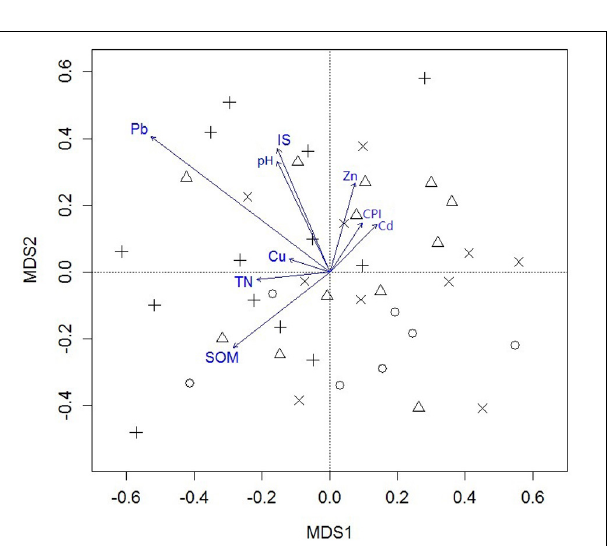
FIGURE 6 | Non-metric multidimensional scaling (NMDS) plot of soil mesofauna community structure (Stress = 0.250; method = Chao) and the environmental variables fitted on the NMDS spaces. IS ratio, impervious surface ratio; SOM, soil organic matter content; TN, soil total nitrogen content; Zn, Cu, Pb, Cd, soil total Zn, Cu, Pb, and Cd concentration, respectively; CPI, heavy metal comprehensive index. Circles: rural forests, triangles: urban forests, pluses: urban woodlands,corsses: urban parks.